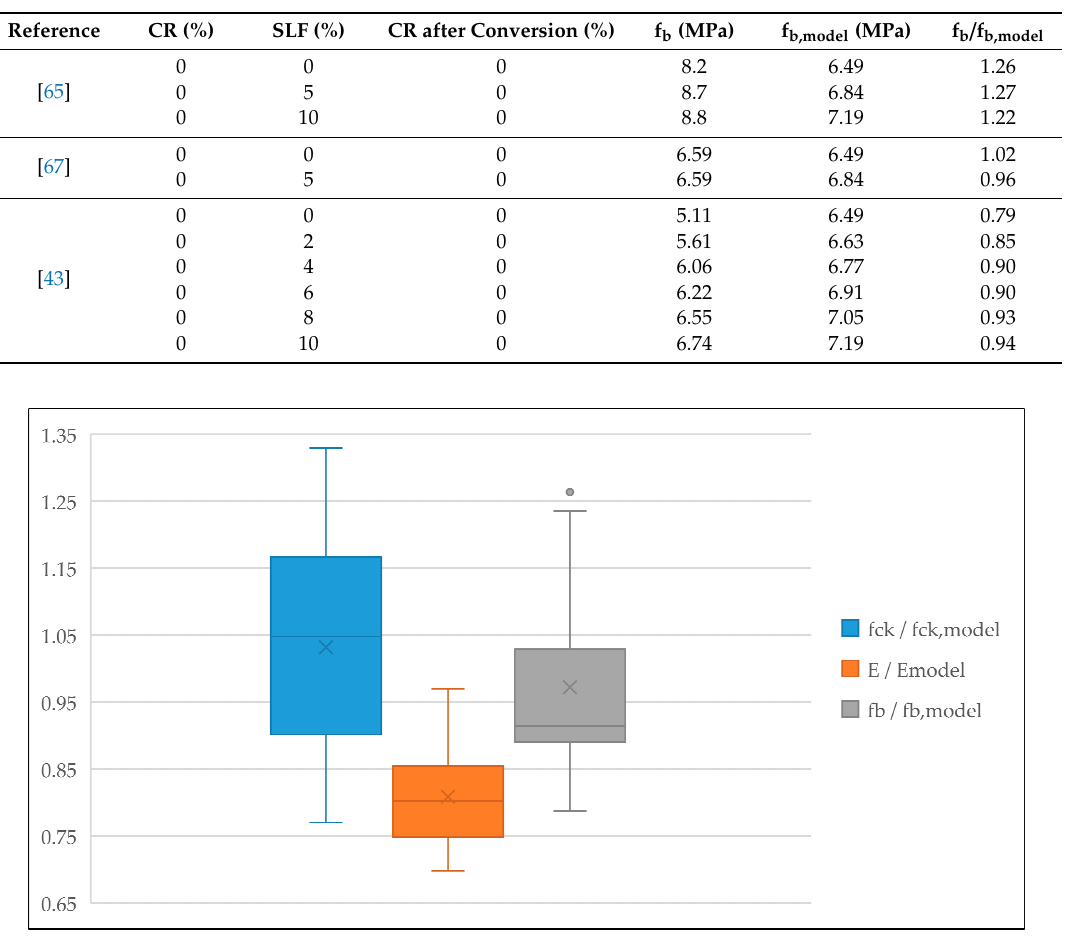
Figure 19. Verification of the prediction model—graphical interpretation.